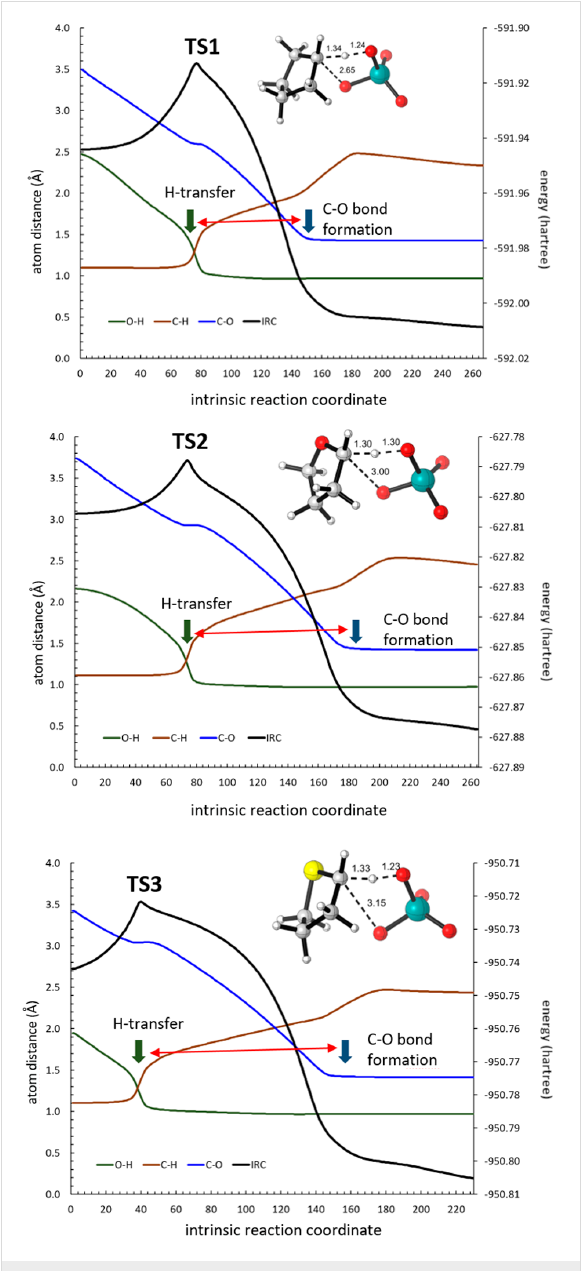
Figure 1: Optimized (B3LYP-d3bj/Def2SVP/cpcm=MeCN) geometries of transition structures corresponding to the oxidation of cyclopentane ( TS1 ), tetrahydrofuran ( TS2 ) and tetrahydrothiophene ( TS3 ). The IRC (black trace) and O–H (green trace), C–H (brown trace), and C–O (blue trace) distances are also given. The double red arrow indicates the delay between H transfer and C–O bond